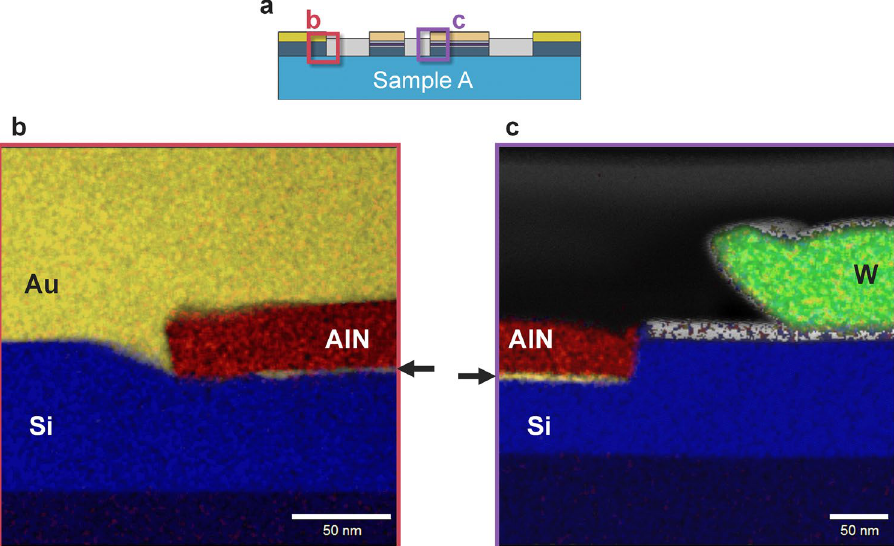
Figure 4. Elemental mapping images of other parts of sample A. ( a ) A schematic cross-section of sample A. The examined areas are indicated by the red ( b ) and the purple ( c ) rectangles. ( b ) The overlay of the elemental mapping around N1. The blue, yellow, and red area indicate Si, Au, and N near the NM electrode. Au was detected from the AlN/Si interface, which is indicated by the arrow. ( c ) The overlay of the elemental mapping around F2. The blue, yellow, red, and green area indicate Si, Au, N, and W near the FM electrode. Au was detected from the AlN/Si interface, which is indicated by the arrow.